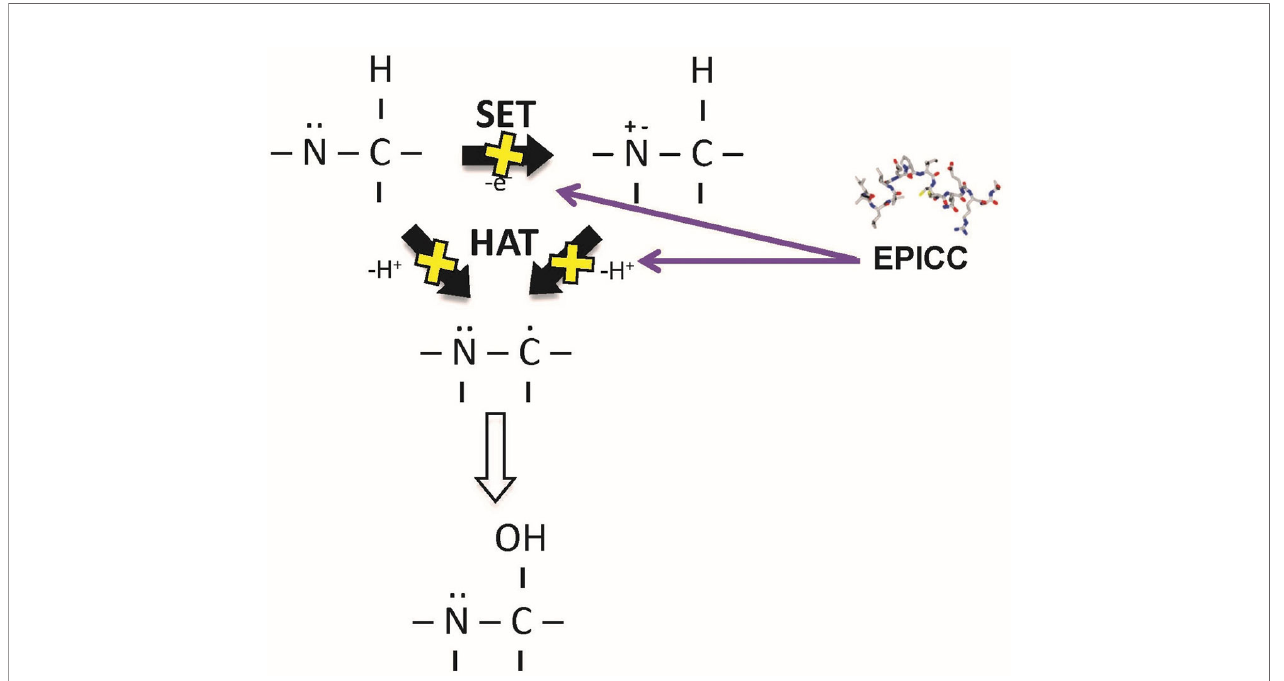
FIGURE 3 | Mechanism of antioxidant activity of the EPICC peptides. EPICC peptides inhibit oxidant formation through the single electron transport (SET) and hydrogen electron transport (HAT) mechanisms. Similar to the cysteine containing tri-amino acid peptide glutathione, EPICC peptide antioxidant activity is mediated by its cysteine